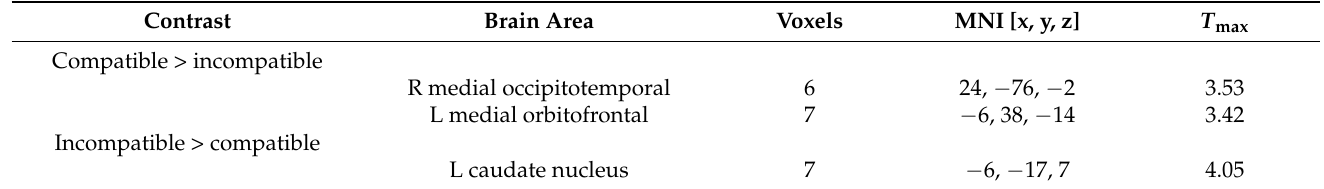
Figure 3. ( A , B ) Significant cluster in left medial OFC associated with approach bias toward chocolate ( p = 0.001 uncorrected at whole brain level, k > 5). ( C ) Extracted beta-estimates from significant cluster indicating stronger deactivation (relative to baseline and null events) under incompatible conditions (avoid chocolate and approach objects) compared to compatible conditions (approach chocolate and avoid objects). Table 1. Results from whole brain analysis for approach bias-related brain activation (statistical threshold: p < 0.001 uncorrected, k > 5 voxels).